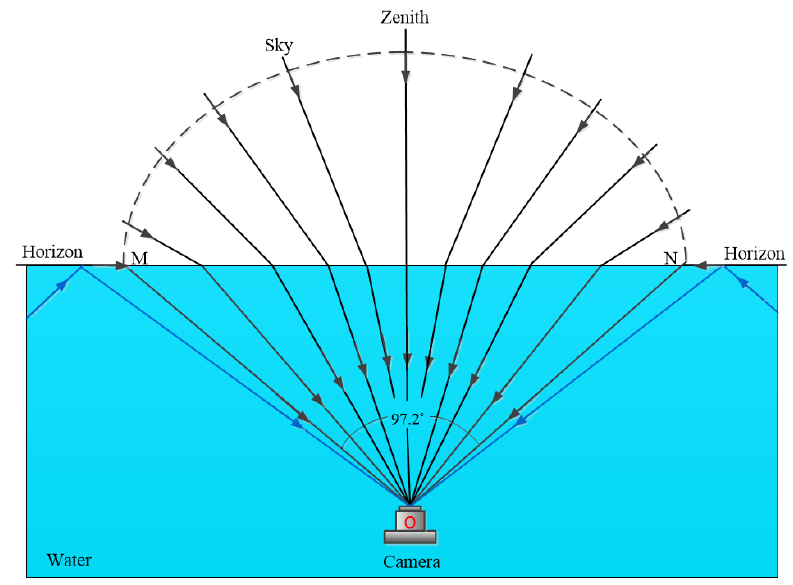
Figure 1. Example of Snell’s window as the WAI is